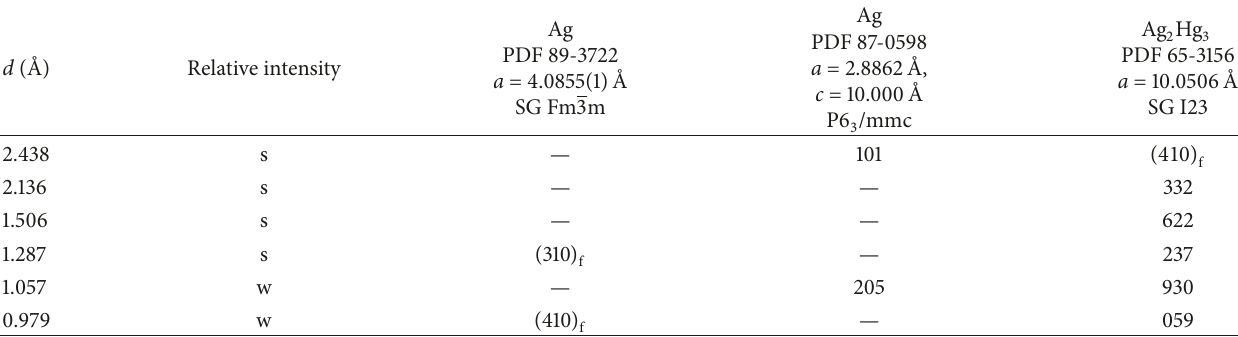
Table 1: SAED data of AgNPs aggregates formed after exposure of silver nanoparticles to Hg 2+ at concentration of 500 𝜇 g L −1 in the presence